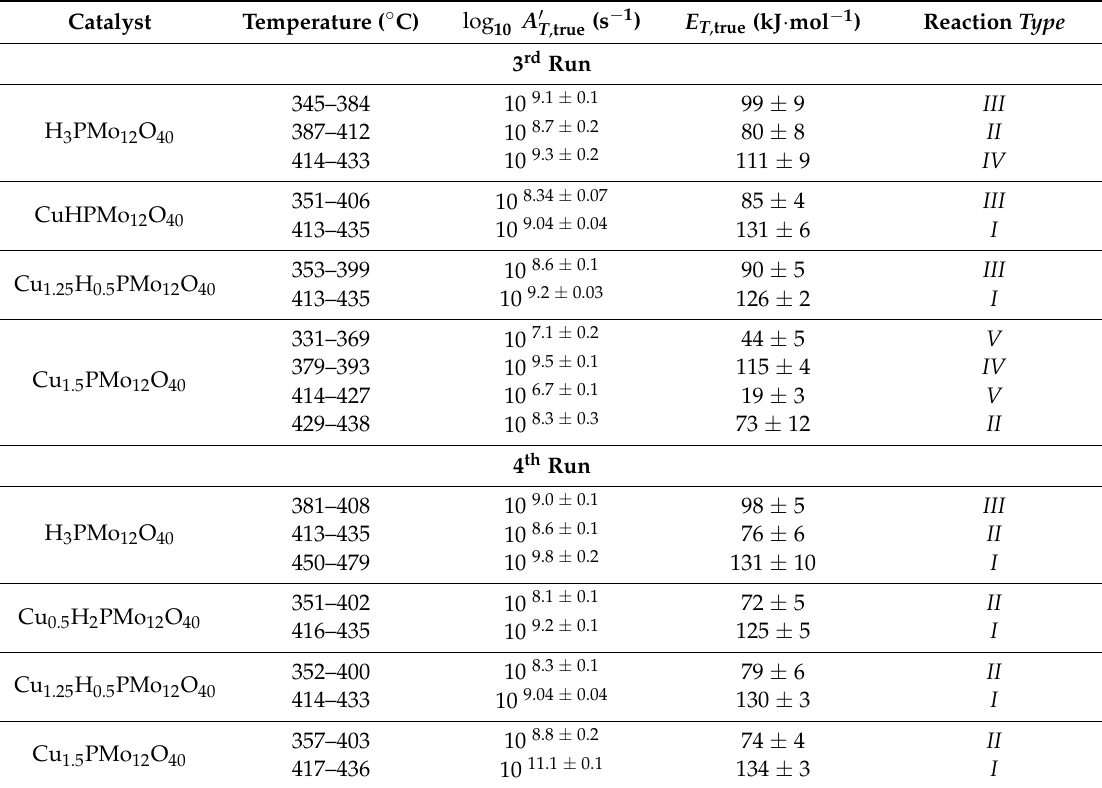
Table 3. Average apparent activation energies and prefactors for distinct maxima and minima during the selective oxidation of isobutane to methacrolein over phosphomolybdic acid and copper(II) phosphomolybdates. Reaction Types I to V are regions with similar average activation energy